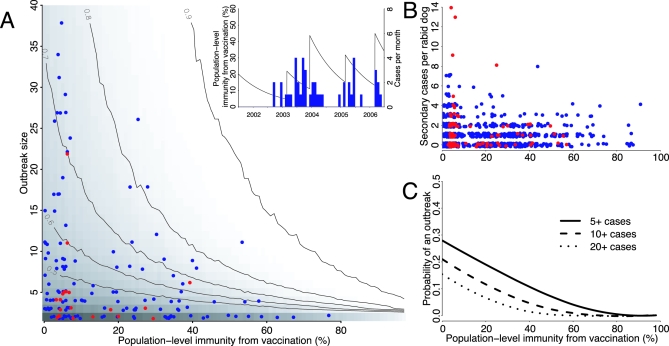
The Impact of Vaccination on Transmission(A) The size of village-level outbreaks (defined as at least two cases not separated by more than one month, isolated cases are assumed to be non-persistent introductions) in Serengeti (blue, n = 138) and Ngorongoro (red, n = 20) districts plotted against village-specific vaccination coverage at the outbreak onset. Coverage was extrapolated from a demographic model initialized with village-specific dog population estimates and incorporating village-specific vaccination data. Gray shading and contours correspond to the probability of observing an outbreak of a particular size or less, generated from 10,000 stochastic simulations of rabies transmission for every initial vaccination coverage (contours were calculated conditional upon >1 secondary case occurring). The inset illustrates a village-level example of the susceptible reconstruction used to calculate instantaneous vaccination coverage plotted beside rabies cases in that village.(B) The distribution of secondary cases per infectious dog as inferred from reconstructed epidemic trees in Serengeti (blue) and Ngorongoro (red) districts, plotted against vaccination coverage in the village where the primary case occurred. Random jitter was added to prevent superposition on the y-axis.(C) Probability of an outbreak being seeded by an introduced case under different levels of vaccination coverage. Due to heterogeneity in the transmission process outbreaks rarely occur when coverage is maintained above P
crit. However if infections are frequently imported from outside the vaccinated region, at least 40% coverage would need to be maintained to reduce the probability of subsequent outbreaks (of at least ten cases) to <0.05.